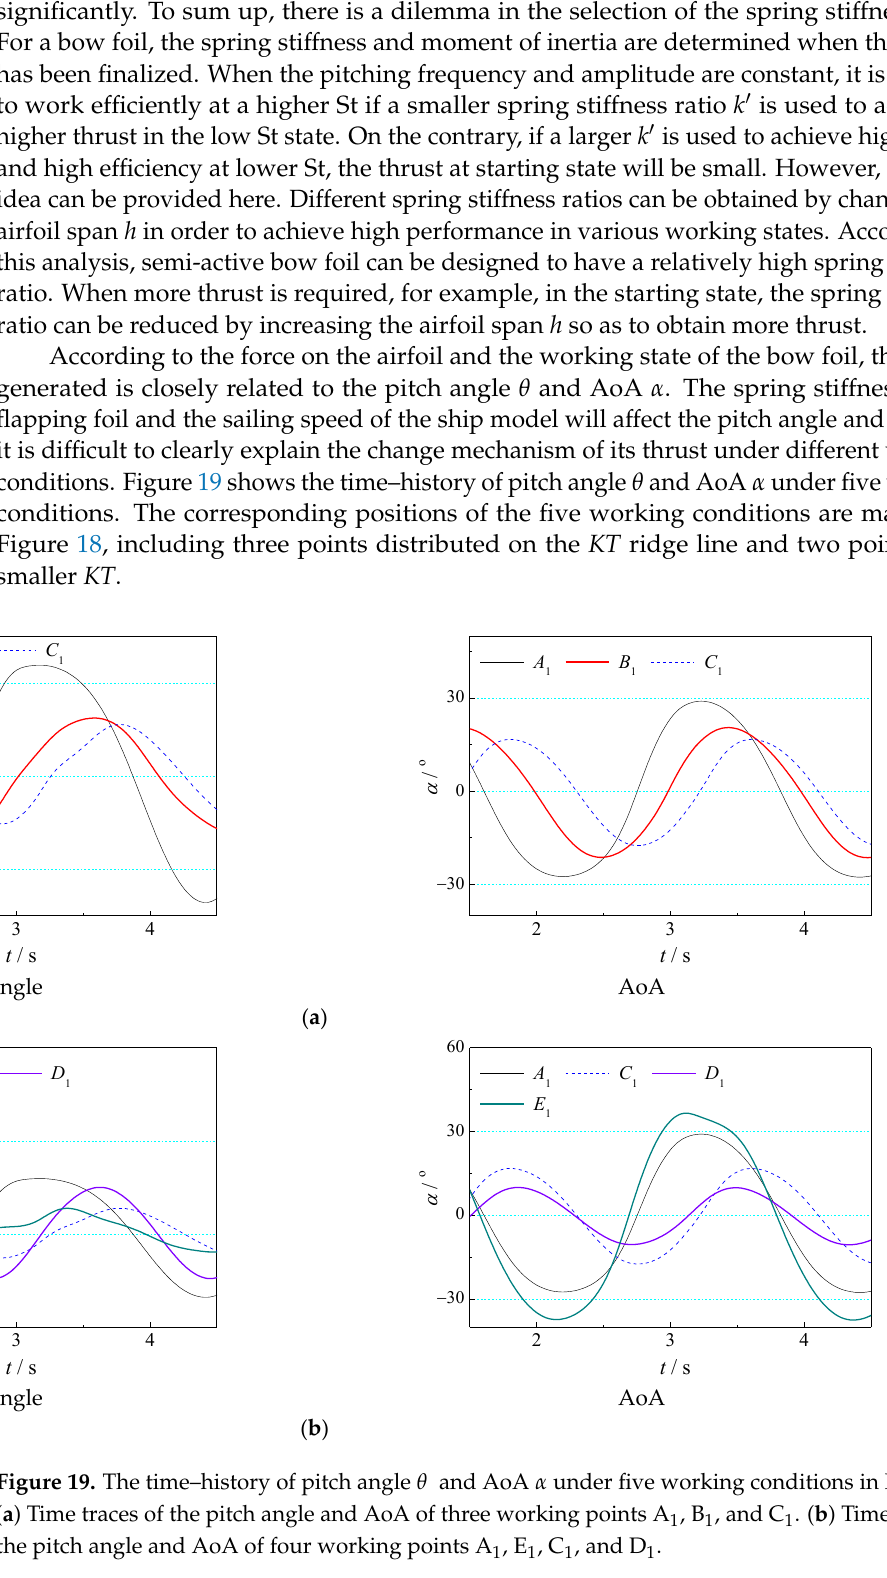
A1 E1 Figure 20. Wake vortex diagrams of working conditions A1 and E1 at the moment of 𝜃 = 0. 4.3. Damping Effect of the Bow Foil Span In the discussion in Section 4.1, it is found that the preliminarily designed bow foil in this paper has little effect on the hull at low speed; that is, it does not fully absorb wave energy, and, at the same time, it cannot well explain the relationship between suppression of hull motion response and hull drag reduction. Therefore, this part will adjust the span of the bow foil in order to increase the hydrodynamic force of the bow foil, thereby en- hancing the coupling relationship between the flapping foil, hull, and waves and explor- ing the interaction between them. In this part, the ship speed V = 1.5 m/s (Fr = 2.0) is selected for analysis; the selected foil spans are h = 0.4 m, 0.6 m, 0.8 m, and 1 m, respectively. Among them, h = 0.8 m is slightly larger than the ship width, while h = 1 m is obviously larger than the ship width. The corresponding aspect ratio of foil is h / c = 2, 3, 4, and 5, respectively. The thrust enhancement ratio and resistance reduction ratio of the bow foil to the hull under different spring stiffness coefficients and span lengths are shown in Figure 21. With